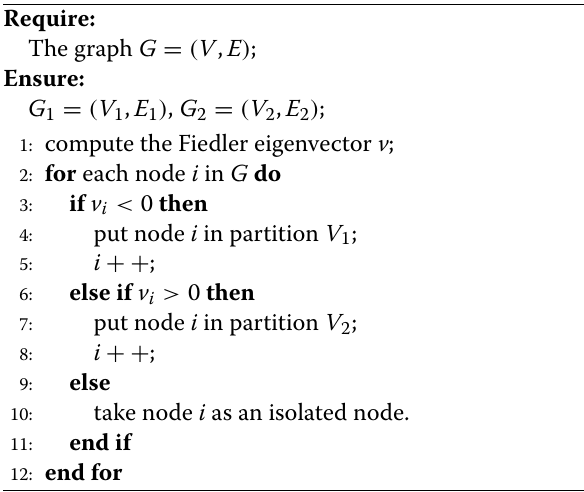
Algorithm 1 Spectral bisection algorithm